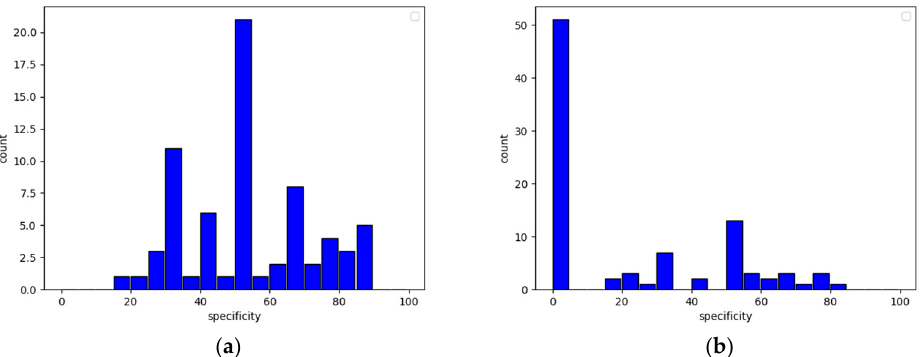
Figure 11. User specificity histogram with undamaged data ( a ) and data without accelerometer axis z ( b ).